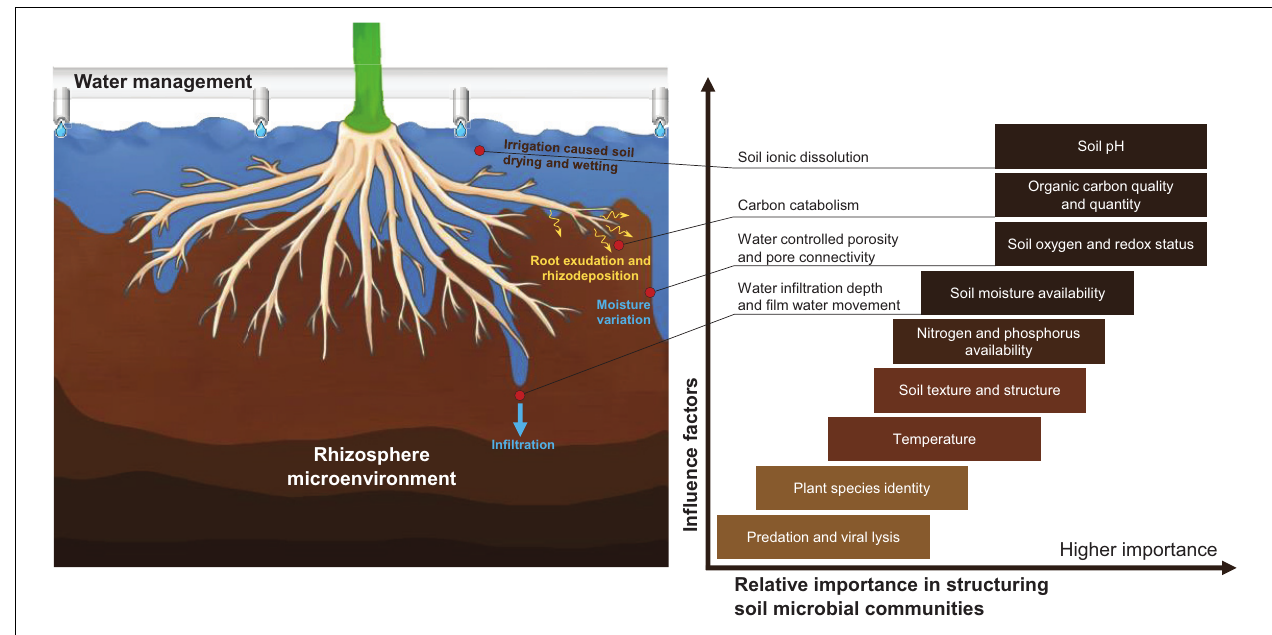
FIGURE 6 | The importance of water management in rhizosphere microenvironments and the factors that structure microbial communities. The box color qualitatively indicates the current understanding of the specific effects of certain factors on microbial communities; darker shades highlight reasonably well-understood factors. The figure is remade using the compilation of the following research studies: Schimel et al. (2007), Lauber et al. (2009), Kuramae et al. (2011, 2012), Okegbe et al. (2014), Maestre et al. (2015), Prober et al. (2015), Fierer